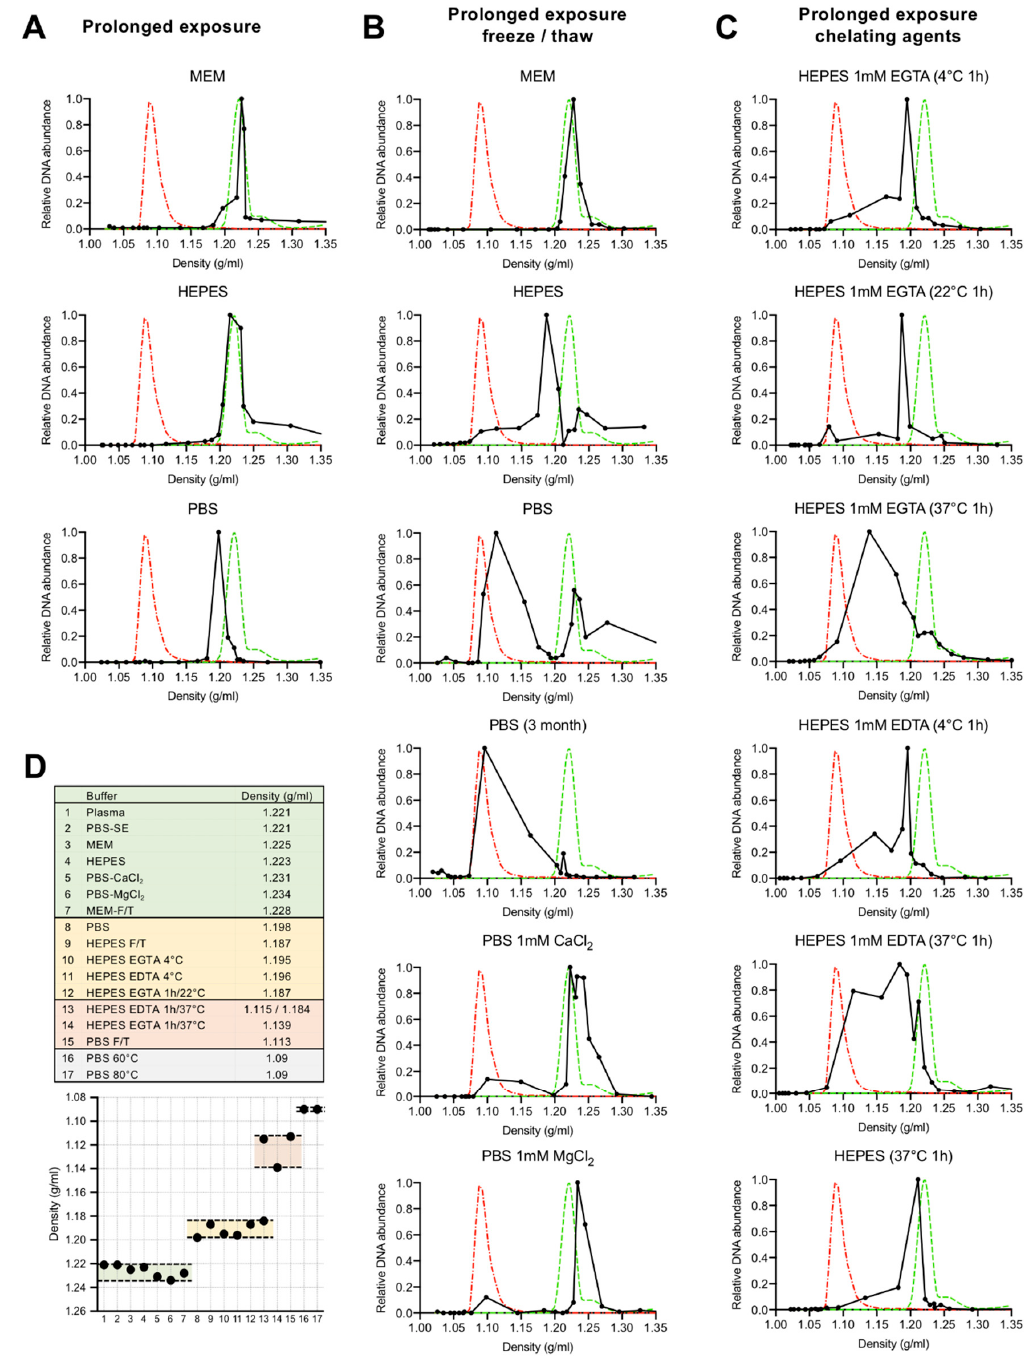
Figure 2. Influence of divalent cation depletion on the density of B19V. Virus from infected plasma was pelleted through 20% sucrose cushion, resuspended in di ff erent bu ff ers and stored at 4 ◦ C for one month. Fractions from iodixanol density gradient ultracentrifugation were quantified by qPCR. ( A ) E ff ect of prolonged (one month) incubation of B19V in MEM, HEPES and PBS at 4 ◦ C. ( B ) E ff ect of a freeze / thaw cycle after prolonged incubation of B19V in MEM, HEPES, PBS and PBS supplemented with 1 mM CaCl 2 or 1 mM MgCl 2 . ( C ) E ff ect of prolonged incubation of B19V in HEPES at 4 ◦ C supplemented or not with 1 mM EGTA or 1 mM EDTA. Before separation by iodixanol density centrifugation, the virus suspensions were treated at 4 ◦ C, 22 ◦ C or 37 ◦ C for 1 h. Green peak; density native virus. Red peak; density free viral DNA. ( D ) Upper panel; summary of the major density peaks (g / mL) of B19V in the di ff erent bu ff ers and exposed to di ff erent conditions. Lower panel; graphic representation of the four distinct density groups. Similar densities appear grouped by